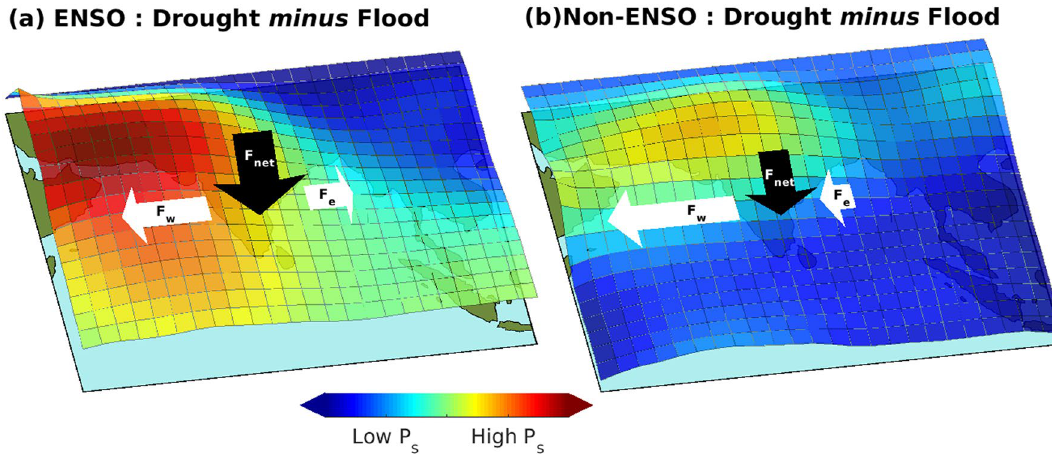
Figure 8. Schematic showing variations in surface pressure surrounding the Indian monsoon region due to ( a ) ENSO and ( b ) Non-ENSO forcing leading to Indian summer monsoon rainfall extremes (drought and flood). The horizontal arrows represent the zonal moisture flux at the western ( F W ) and eastern ( F E ) boundaries. The vertical arrow indicates the net moisture convergence ( F net ) over the Indian domain. This figure was created using MATLAB version R2020b (https:// in. mathw orks.